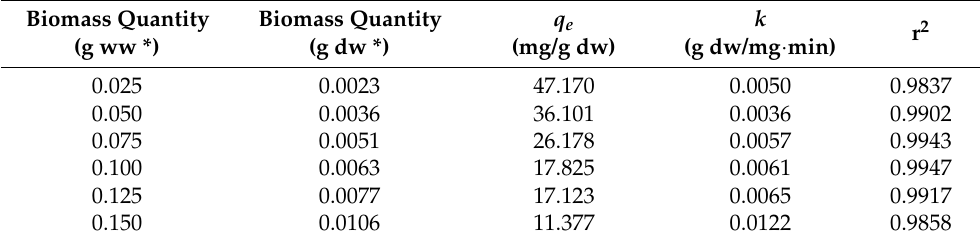
Table 4. Parameters of the pseudo-second-order model kinetic model adjusted to the Ag biosorption on different quantities of Cladosporium cladosporioides